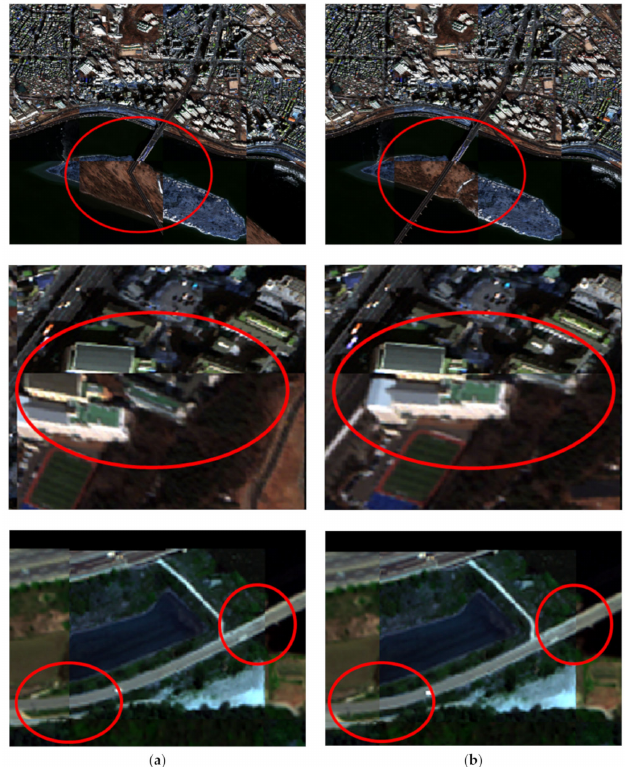
Figure 8. Magnified warping results over the image boundary between the warped and the reference images: ( a ) Piecewise linear (PL) transformation and ( b ) improved piecewise linear (IPL)